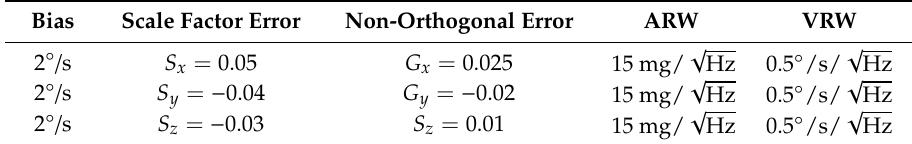
Table 7. Simulated Error Parameters.